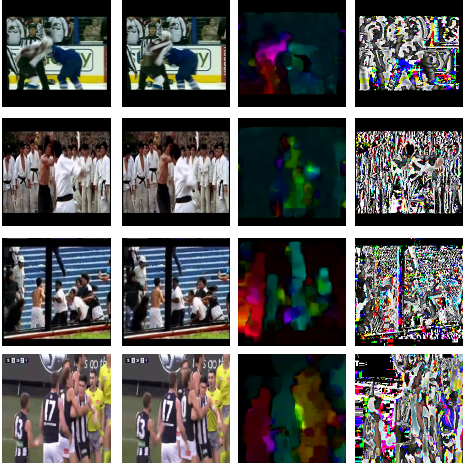
Figure 2. Transformation of sequences of two consecutive frames, of four violent scenes for each dataset (columns 1 and 2), in their dense optical flow (column 3) and adjacent frame subtraction (column 4). The color in (column 3), is for better